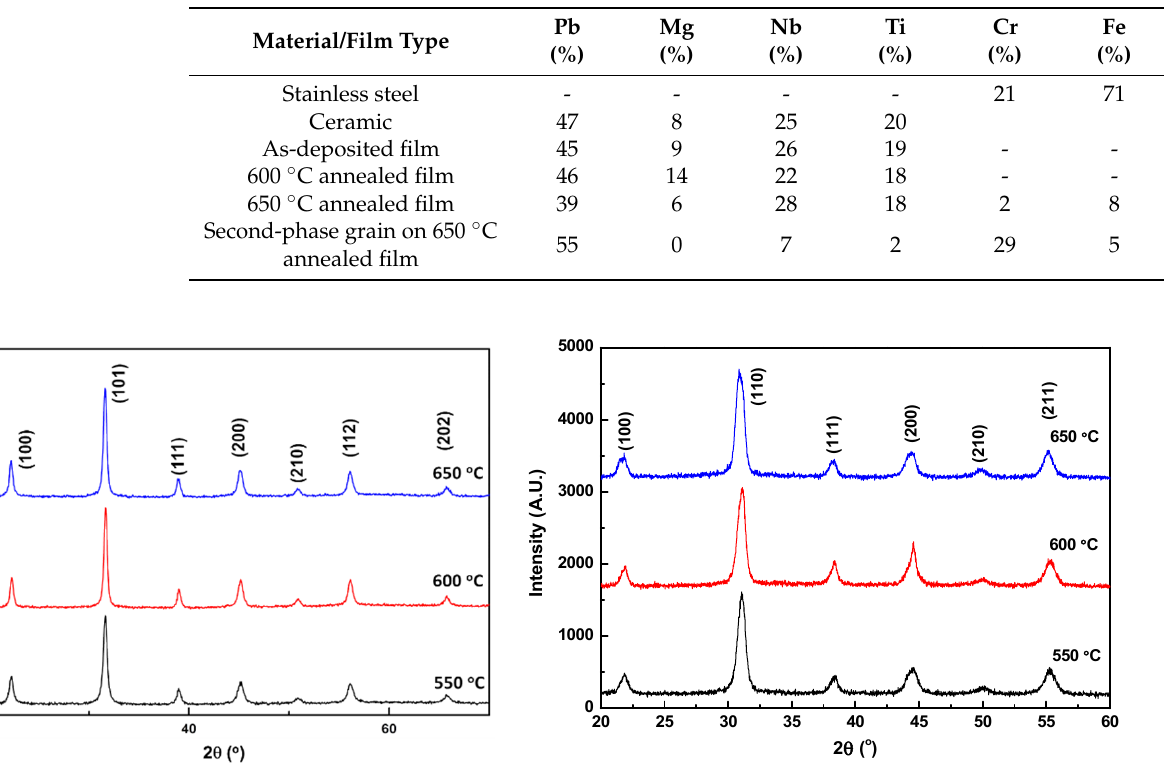
Table 2. Atomic composition of the as-deposited and annealed PMN–PT films.